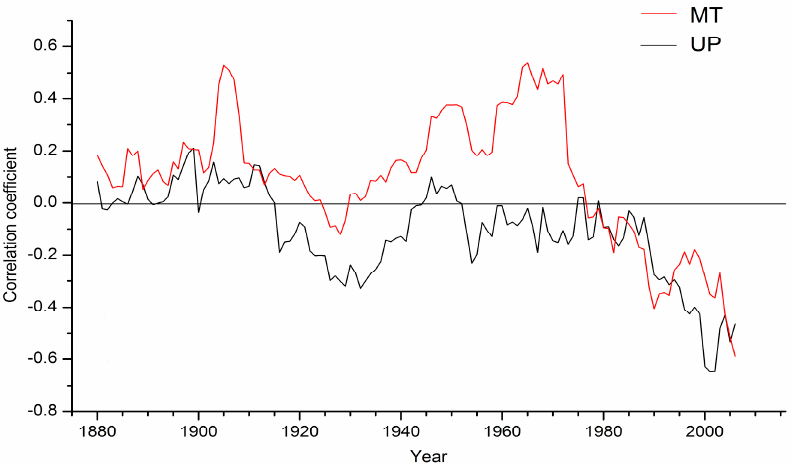
Figure 6. Twenty-one-year running correlation between tree-ring chronologies and April–May Niño 3.4.